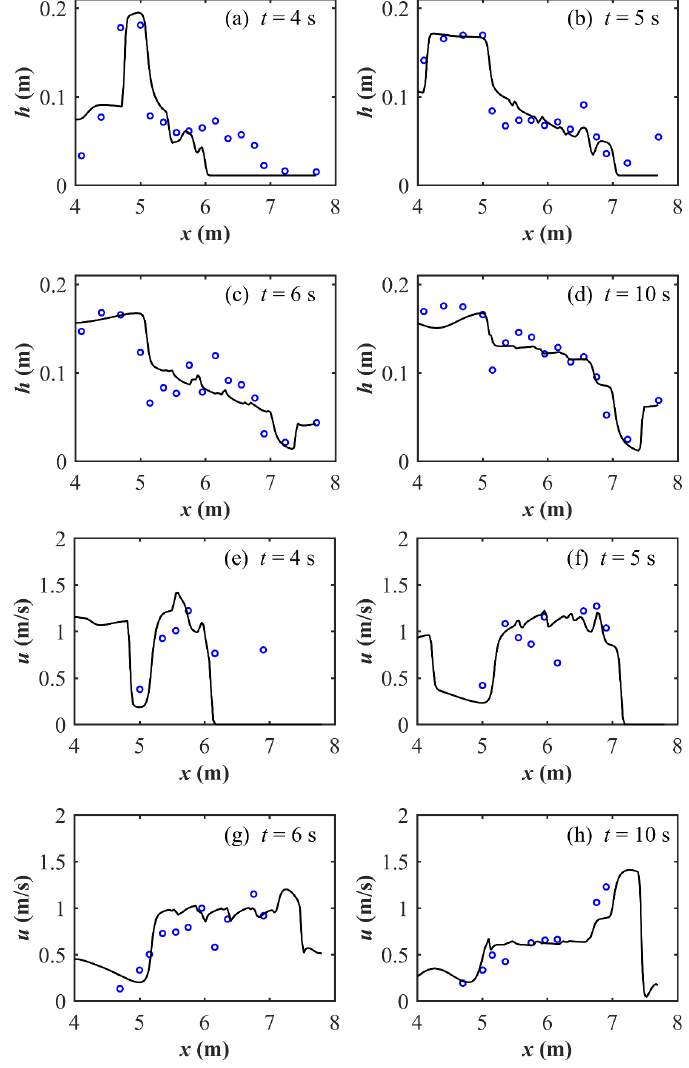
Figure 6. Computed and measured hydrodynamics: ( a – d ) water level profiles; ( e – h ) flow velocity profiles along the B-B section at four transients.